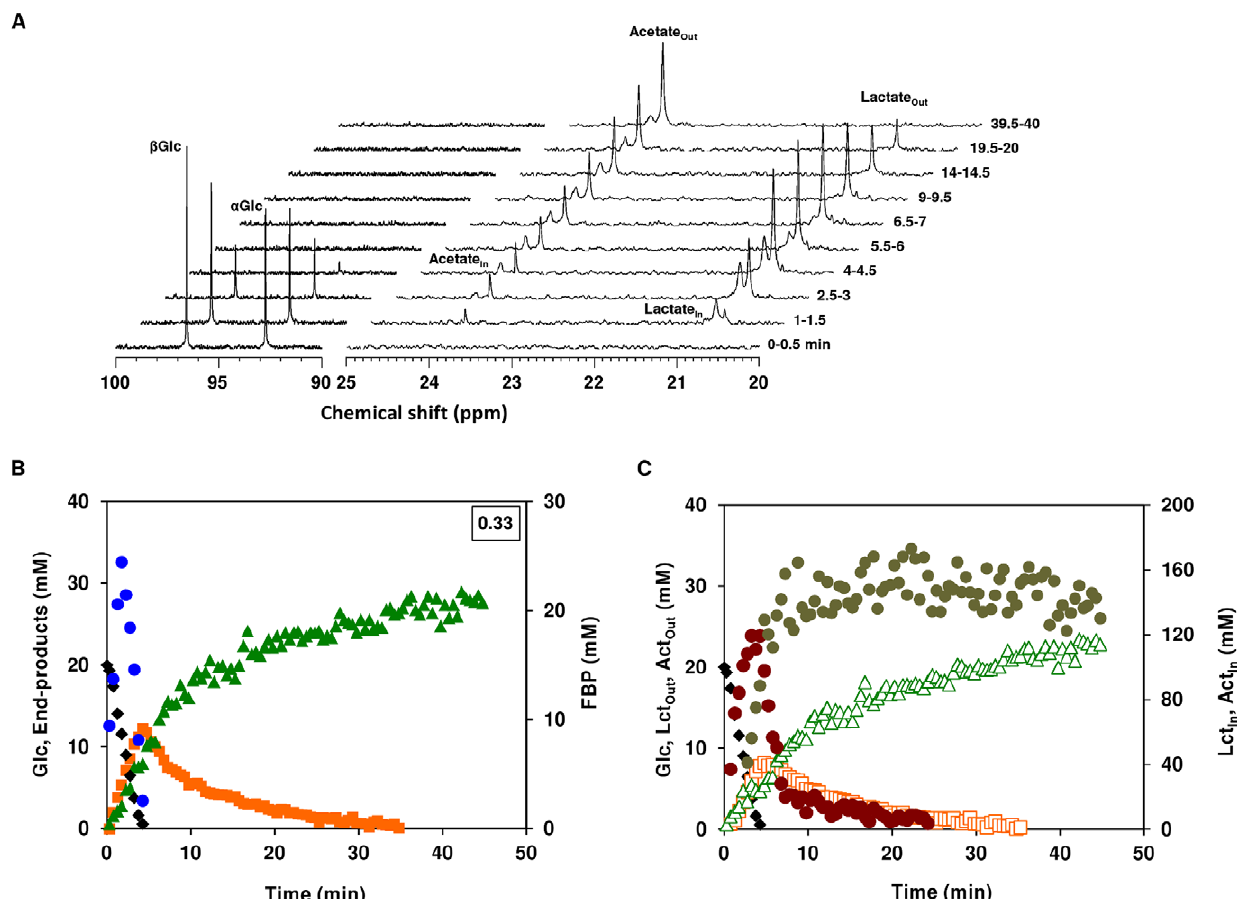
Figure 2. Aerobic glucose metabolism in aerobically-grown S.aureus as monitored by invivo 13 C-NMR. Sequence of 13 C-NMR spectra acquired during the metabolism of 20 mM [1- 13 C]glucose by a cell suspension of COL-S under aerobic conditions at 37 u C. Cells were suspended in 100 mM KP i pH 7.0, at a concentration of 30 mg of DW ml 2 1 . Each spectrum represents 30 s of acquisition. Glucose was added at time zero, each spectrum was acquired during the indicated interval, and processed with a 2 Hz line broadening (A). Kinetics of [1- 13 C]glucose (20 mM) consumption, end-products formation and phosphorylated intermediates in S. aureus COL-S. Maximal glucose consumption rates ( m mol min 2 1 mg 2 1 of protein) are boxed in the upper-right corners (B). Dynamics of intra- and extracellular pools of lactate and acetate; Glc is also shown for the sake of clarity (C). Symbols: (black diamond), glucose; (orange square), total lactate; (green triangle), total acetate; (blue circle), FBP; (open orange square) extracellular lactate; (brown circle) intracellular lactate; (open green triangle) extracellular acetate; (olive circle) intracellular acetate. Total lactate and acetate are the sum of extra- and intracellular concentrations without correcting the latter for the internal volume.